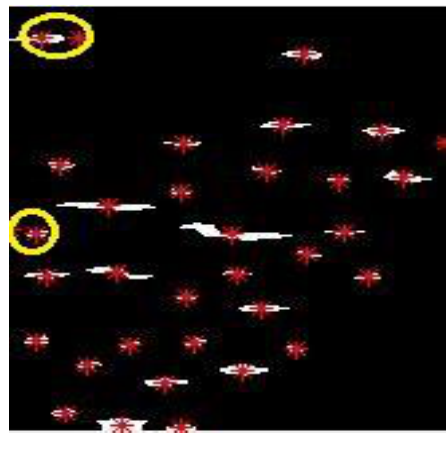
Fig. 6 ALOS PALSAR -1 sub-image B output Table 3 ALOS-1 Vessels detection rate of Sub-image (B)